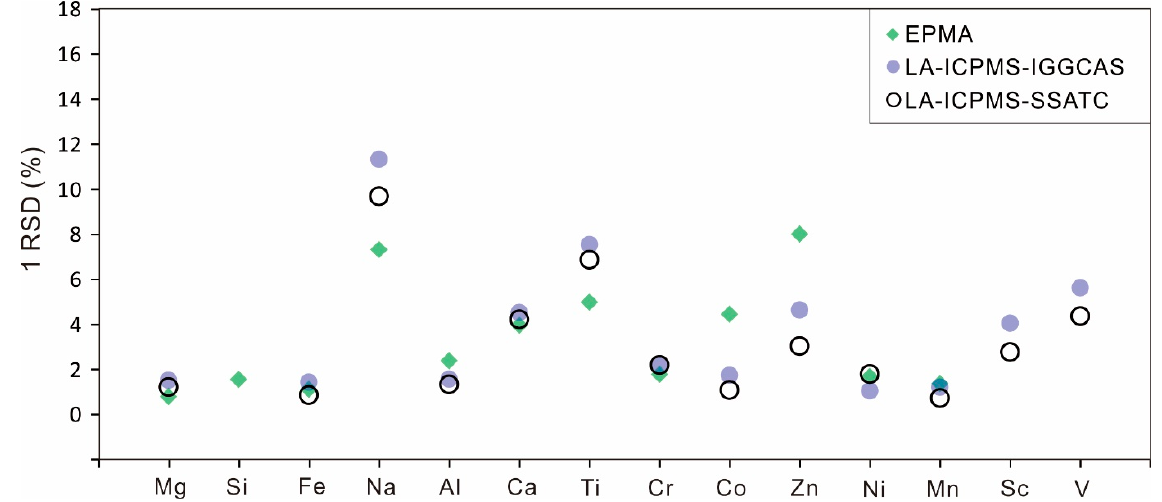
Figure 4. EPMA and LA-ICPMS homogeneous data for MK-1 orthopyroxene. The relative standard deviations (RSDs) display the dispersion of the data.